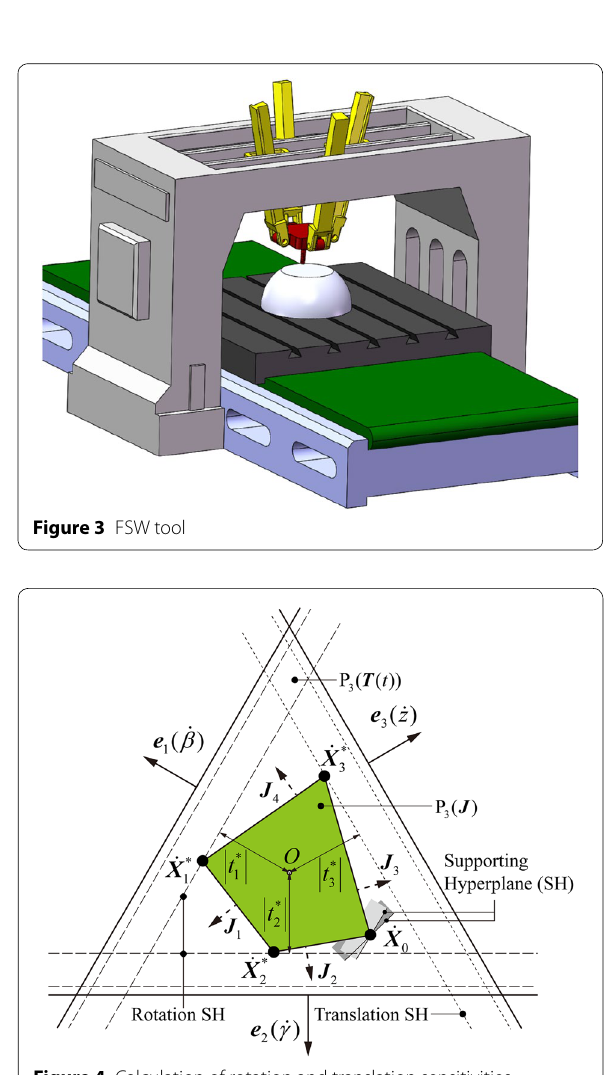
Figure 4 Calculation of rotation and translation